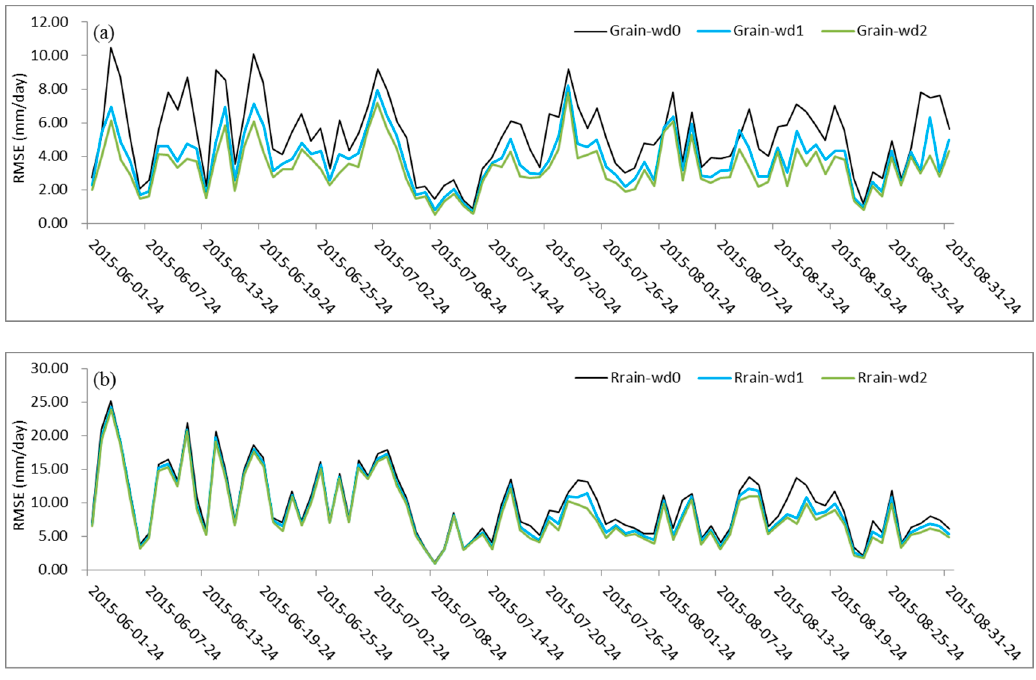
Figure 15. Same as Figure 14, but for RMSE.